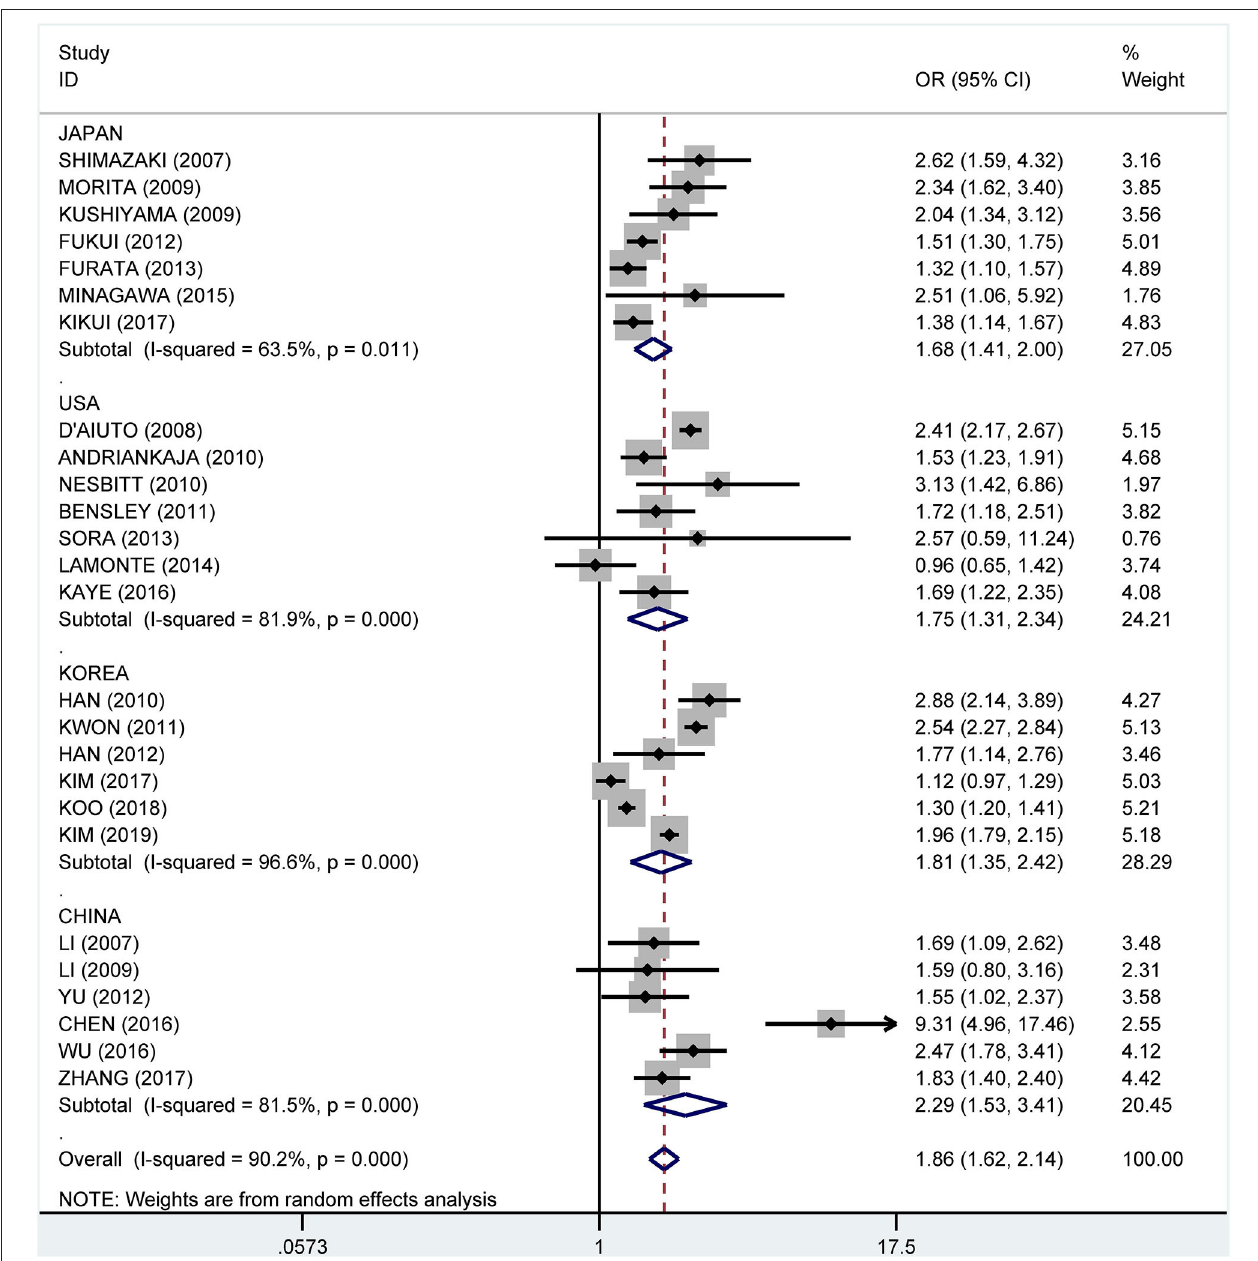
FIGURE 9 | Subgroup analysis of pooled crude odds ratios of the association between periodontitis and metabolic syndrome by